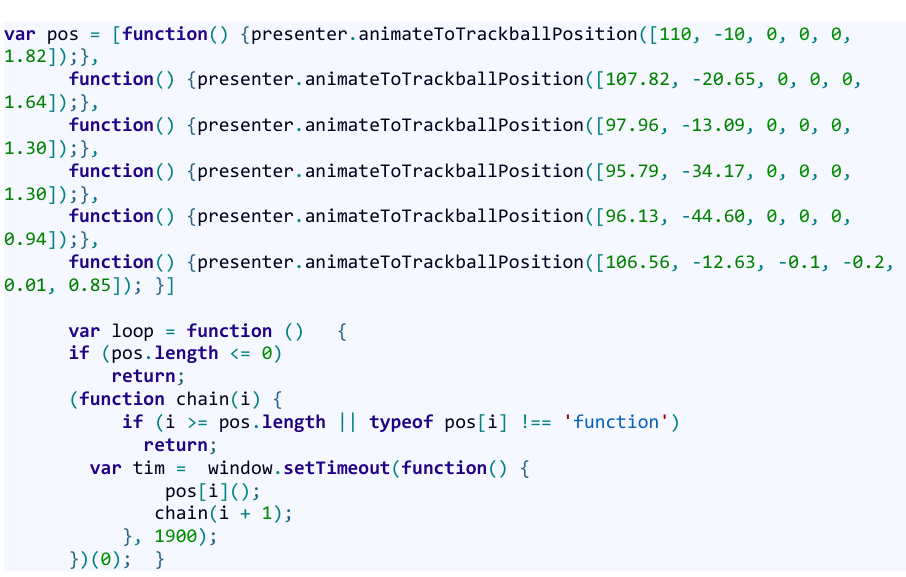
Figure 12. The JavaScript setTimeout method iterates “pos”, the array that contains the anonymous functions with parameter a 3DHOP’s exposed method, within a callback function.